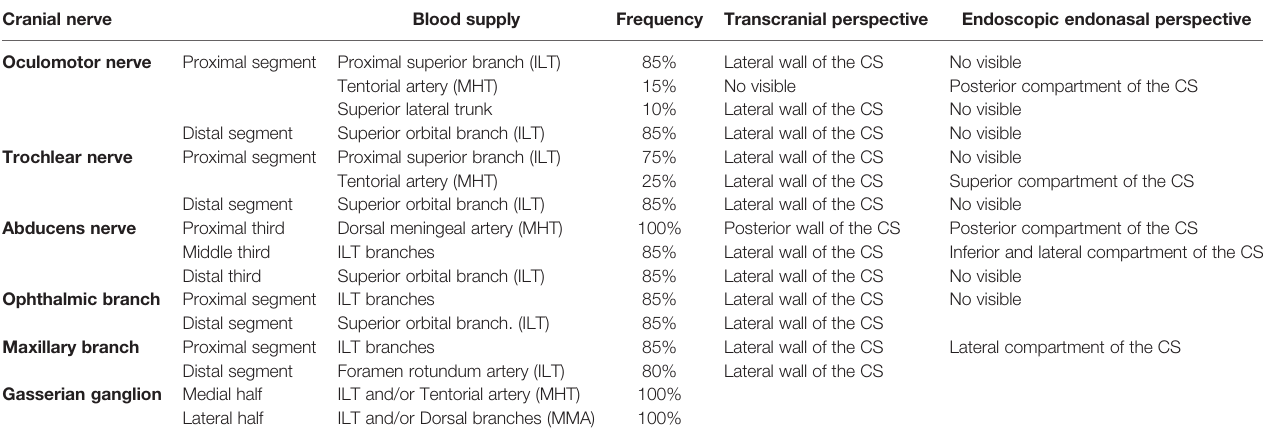
TABLE 1 | The Blood Supply of Intracavernous Cranial Nerves: Microscopic and Endoscopic perspective. Cranial